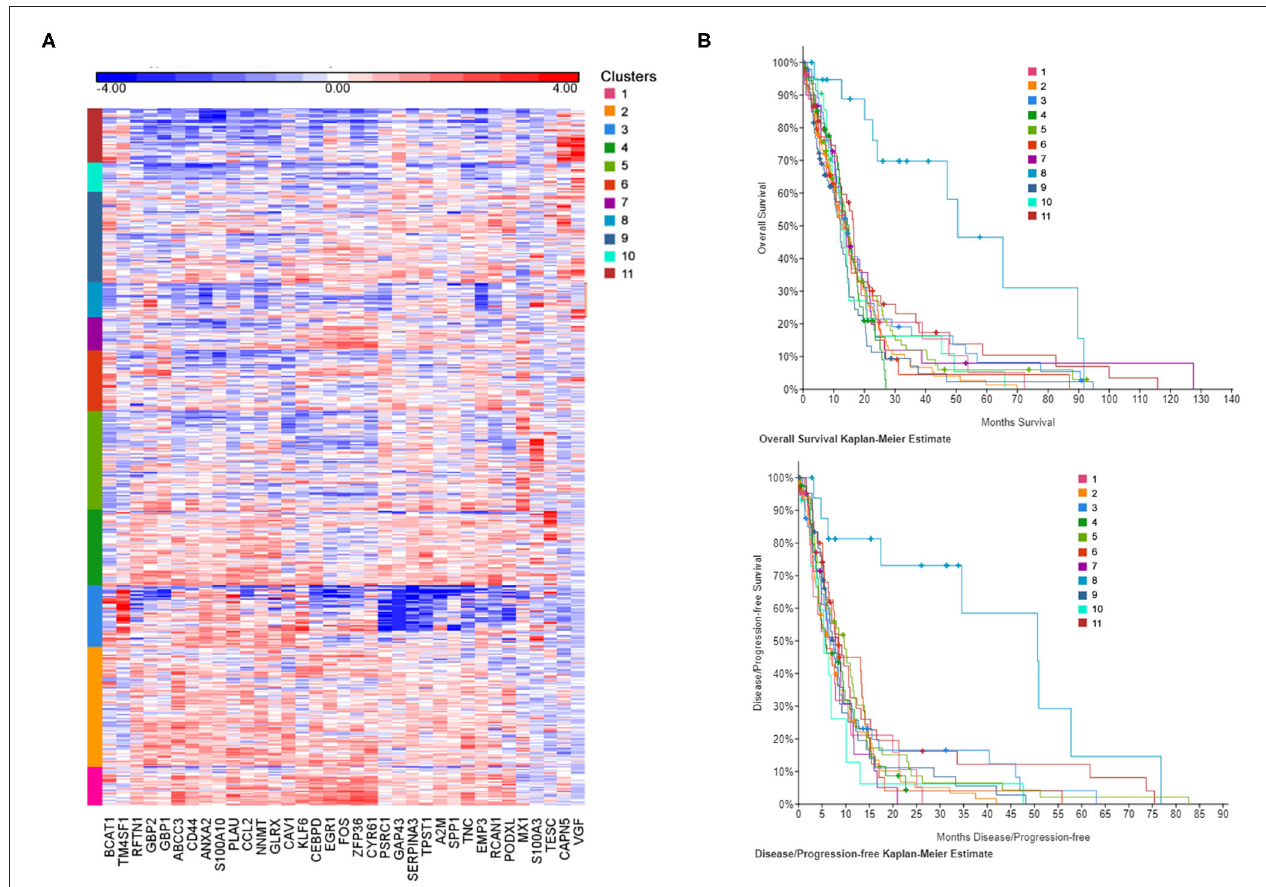
FIGURE 3 | CSF-induced gene signature influence survival in GBM patients. (A) The heat map represents each expression component. Each row represents a patient sample and each column a gene selected for a CSF-induced signature in GBM in vitro . For each patient, red indicates upregulation, blue indicates downregulation. Clusters (1–11) are color coded and represent gene-specific expression patterns. (B) Overall survival and disease/progression free Kaplan-Meier plots for the clusters derived by CSF-induced gene expression show a distinct cluster (8) with significant better clinical features.